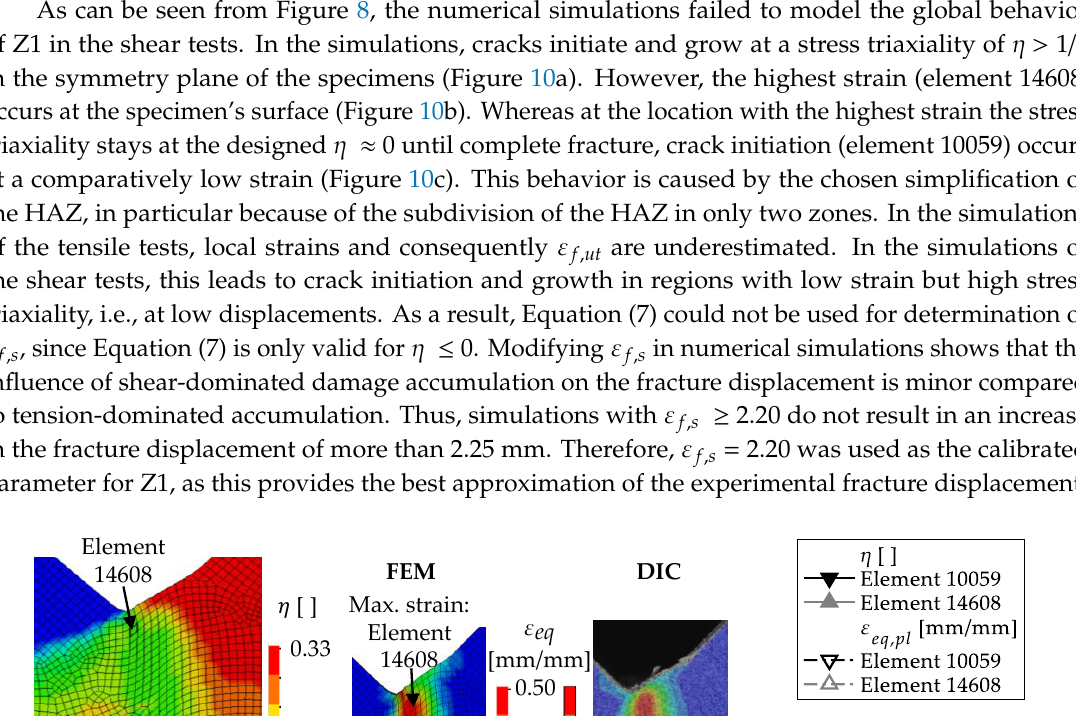
finite element (FE) simulations with the BW criterion.